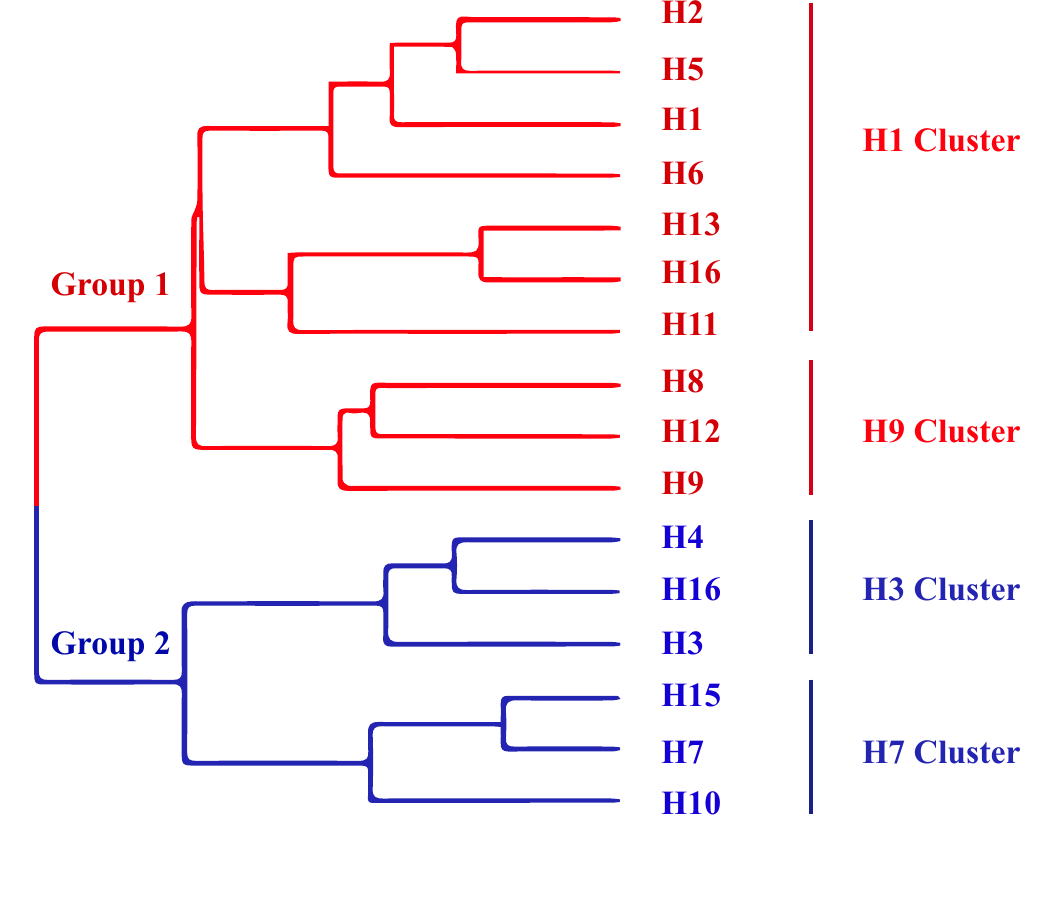
Figure2. PhylogenetictreeofHAsofdi ff erentsubtypes(H1–H16)ofinfluenzaviruses. Thephylogenetic tree was constructed using the neighbor-joining (NJ) method within MEGA software (version 7.0). The colors of the trees are edited using Adobe Illustrator software. The scale bar indicates the average number of amino acid substitutions per